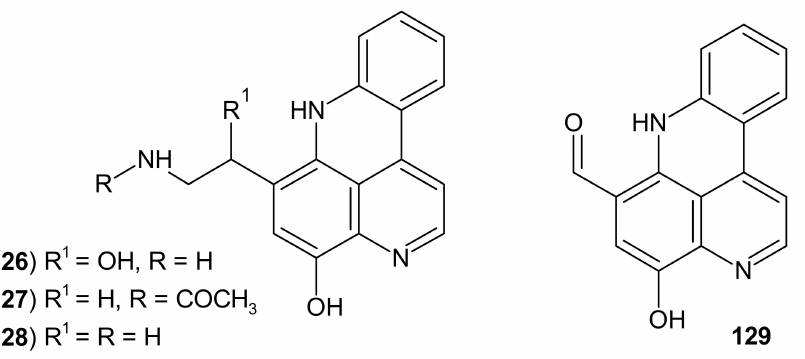
Figure 33. Styelsamines A–D 126 – 129